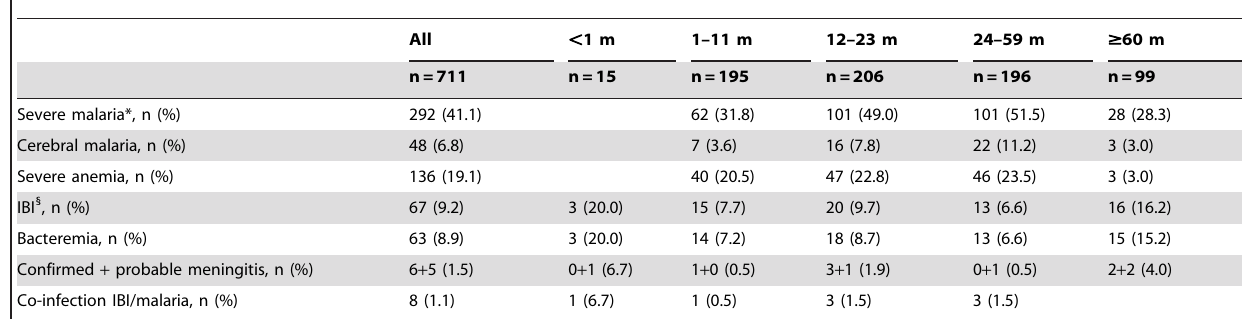
Table 2. Severe malaria and invasive bacterial infections by age